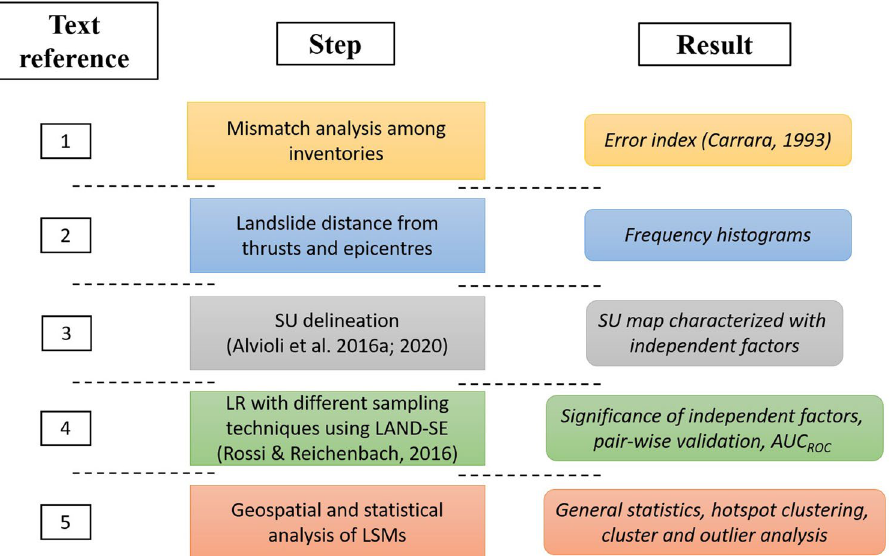
Figure 2. An illustration of the steps performed in this work to compare different inventories and the corresponding LSMs ( cf. Section